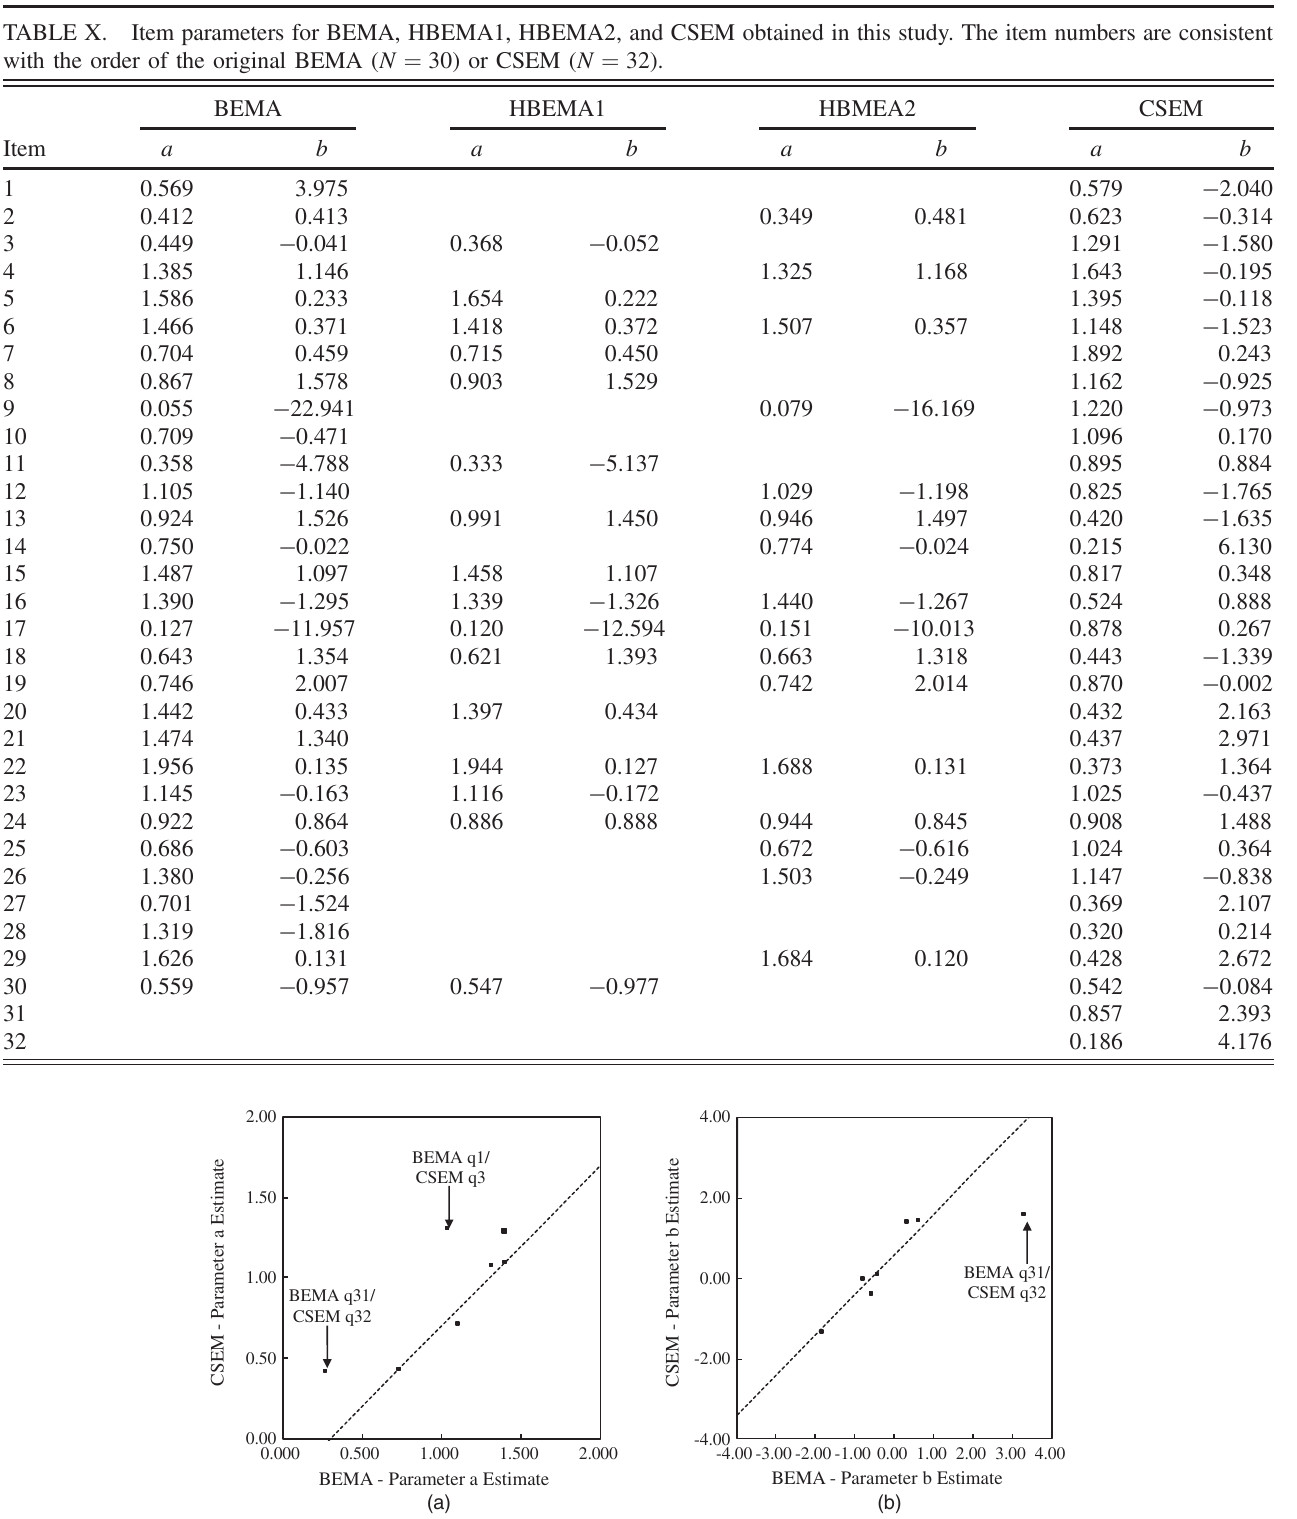
FIG. 9. Plots of parameters for the common items estimated from BEMA and CSEM. When the two estimates produce parameters based on similar latent constructs, these parameters should be in the vicinity of a straight line [4]. Therefore, these plots can be used to look for outliers, which are labeled on the diagrams. In these plots, two reference lines (dashed) are added for direct comparison. In Fig. 9(a) two item pairs (BEMA q1/CSEM q3 and BEMA q31/CSEM q32) appear to be outliers for the a -parameter estimate. In Fig. 9(b), the item pair BEMA q31/CSEM q32 also appears to be an outlier for the b -parameter estimate. Because these item pairs appear to function differently in the two tests, it is recommended to remove them from the list of common anchoring